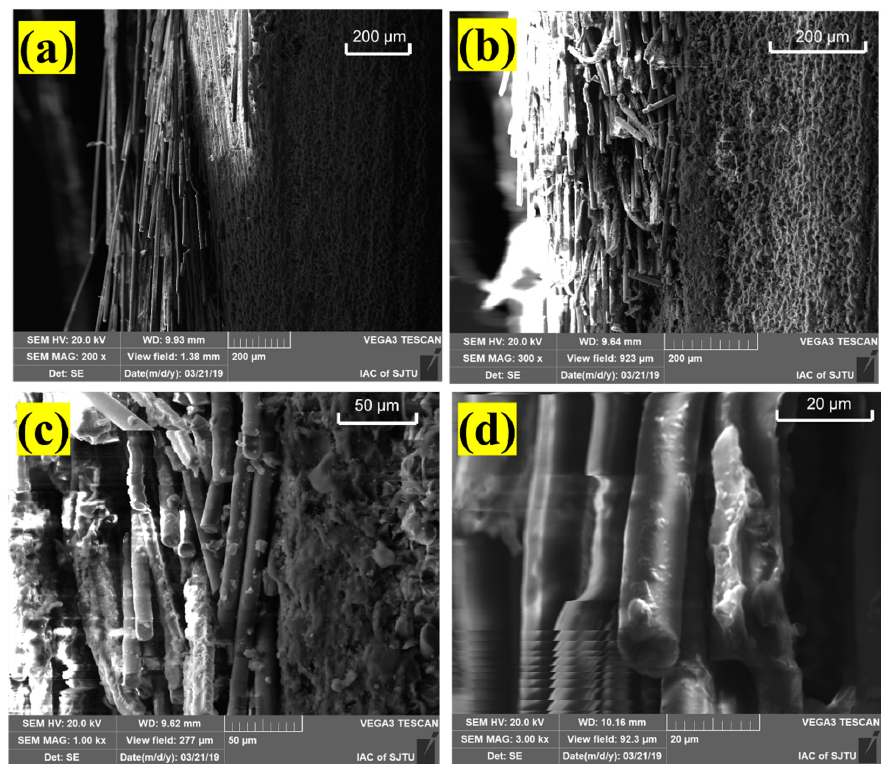
Figure 16. The microscopic morphology of the GFRC laminate after ablation with a C component of 30 kA. With different magnification: ( a ) 200 x, ( b ) 300 x, ( c ) 1.00 kx and ( d ) 3.00 kx. 30 kA. With different magnification: ( a ) 200 × , ( b ) 300 × , ( c ) 1.00k × and ( d ) 3.00k ×